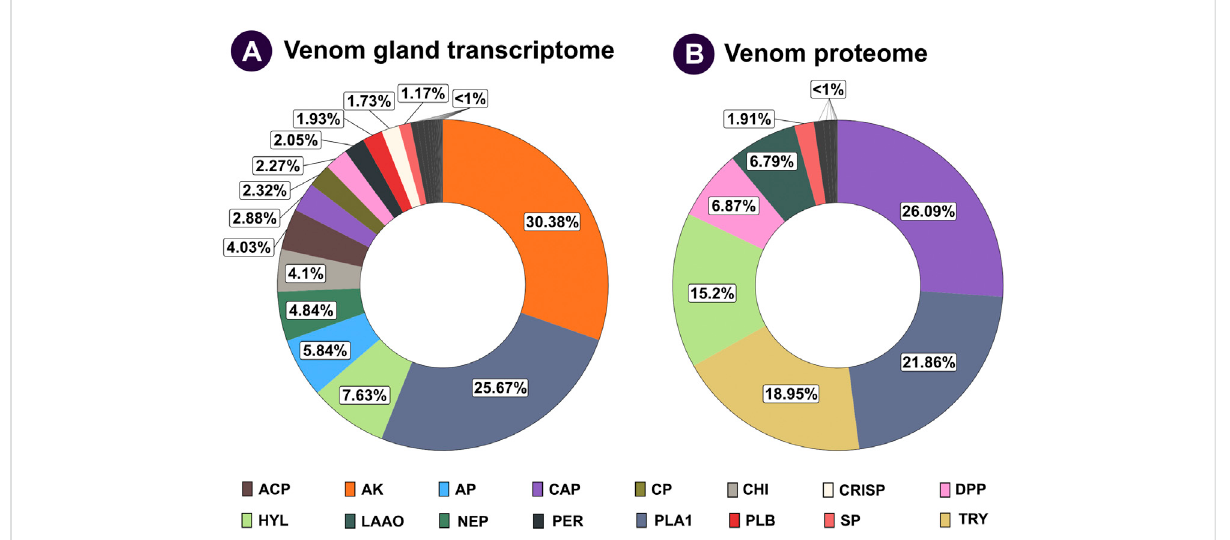
FIGURE 2 Comparative venom gland transcriptome and venom proteome of the lesser banded hornet. The venom gland transcriptome and venom proteome of V. af fi nis are shown as doughnut charts in panels (A) and (B) , respectively. Each toxin is uniquely colour coded, and its relative abundance is mentioned in percentages: ACP: acid phosphatase; AP: aminopeptidase; AK: arginine kinase; CAP: antigen 5, and pathogenesis- related one proteins; CP: carboxypeptidase; CHI: chitinase; CRISP: cysteine-rich secretory proteins; DPP: dipeptidyl peptidase; HYL: hyaluronidase; LAAO: L-amino acid oxidases; NEP: neprilysin; PER: peroxiredoxin; PLA 1 : phospholipase A 1 ; PLB: phospholipase B; SP: serine protease; TRY: